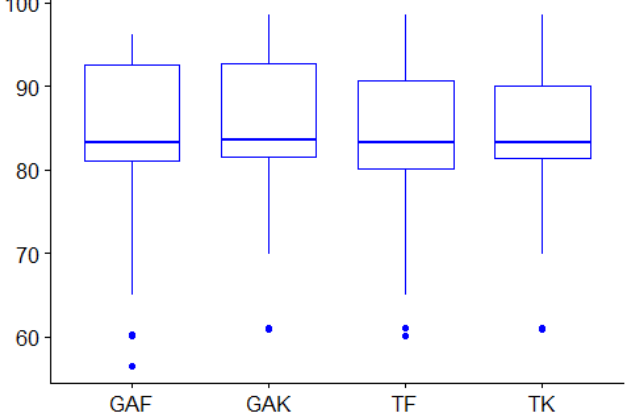
Figure 7. Boxplot of the accuracy obtained by SVM after applying PPFS methods for all the datasets. The y-axis represents the minimum, first quartile, median, third quartile, and maximum value of the accuracy